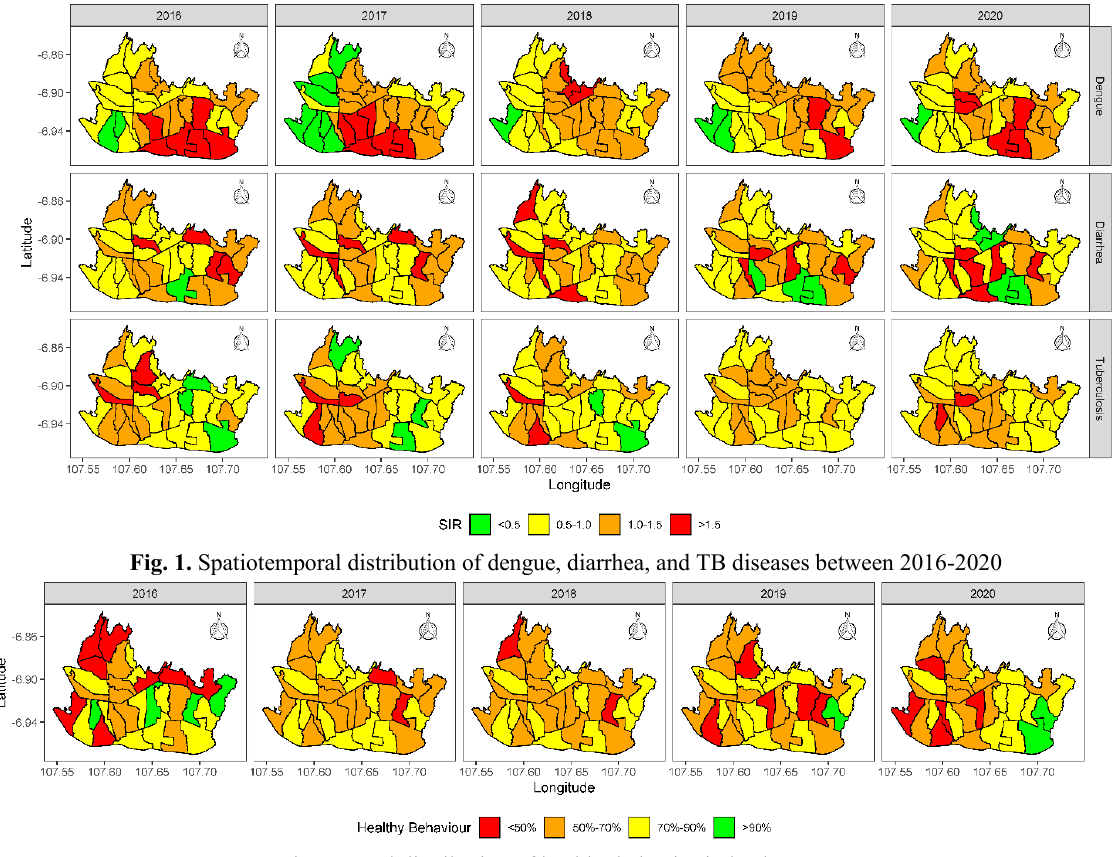
Fig. 2. Spatiotemporal distribution of healthy behavior index between 2016-2020